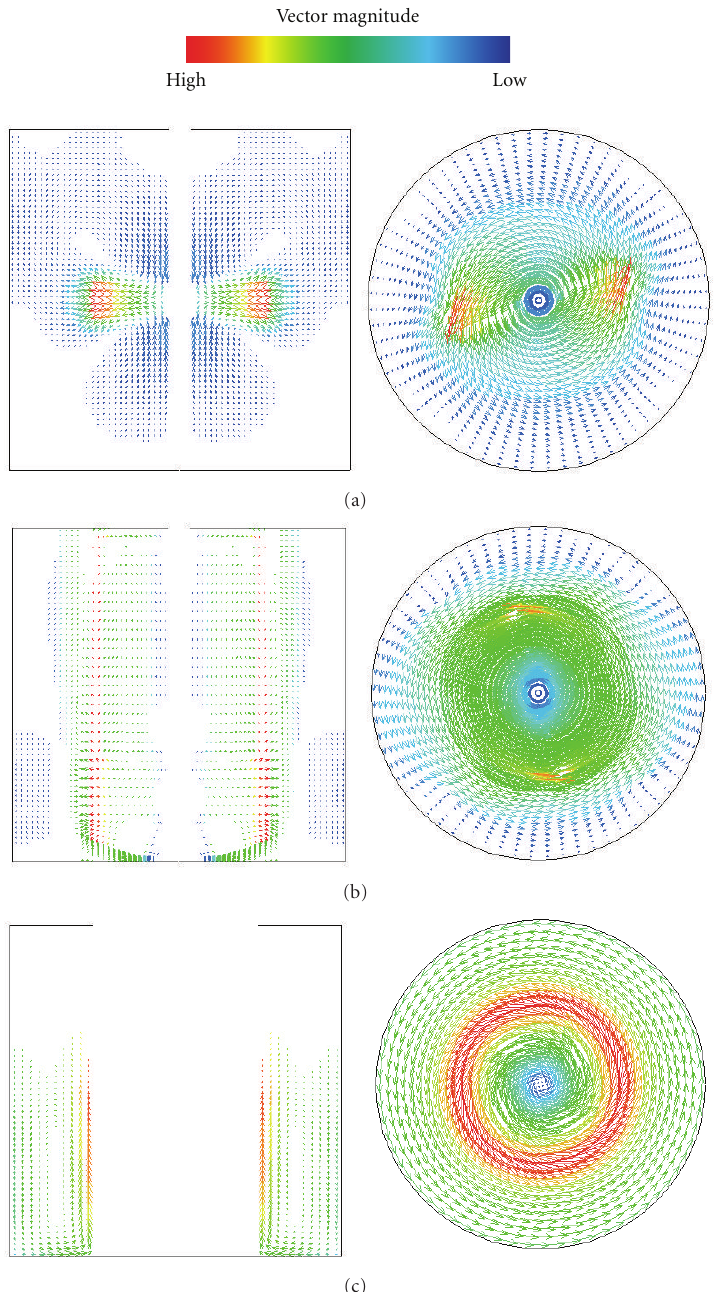
Figure 4: The flow velocity-vector patterns of three types of impellers in the vertical and horizontal directions (cross-section containing impeller blade and shaft) ( n r = 100 rpm); (a) 2-BP (with 4 ba ffl es), (b) MB (with 4 ba ffl es), (c) RC (without ba ffl